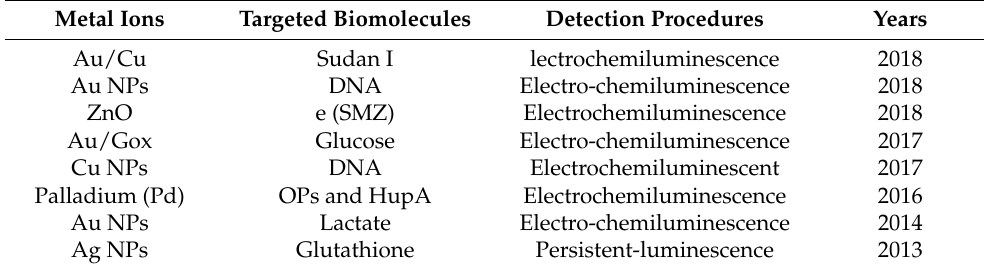
Table 1. Metal based CNs biomaterials for medical uses